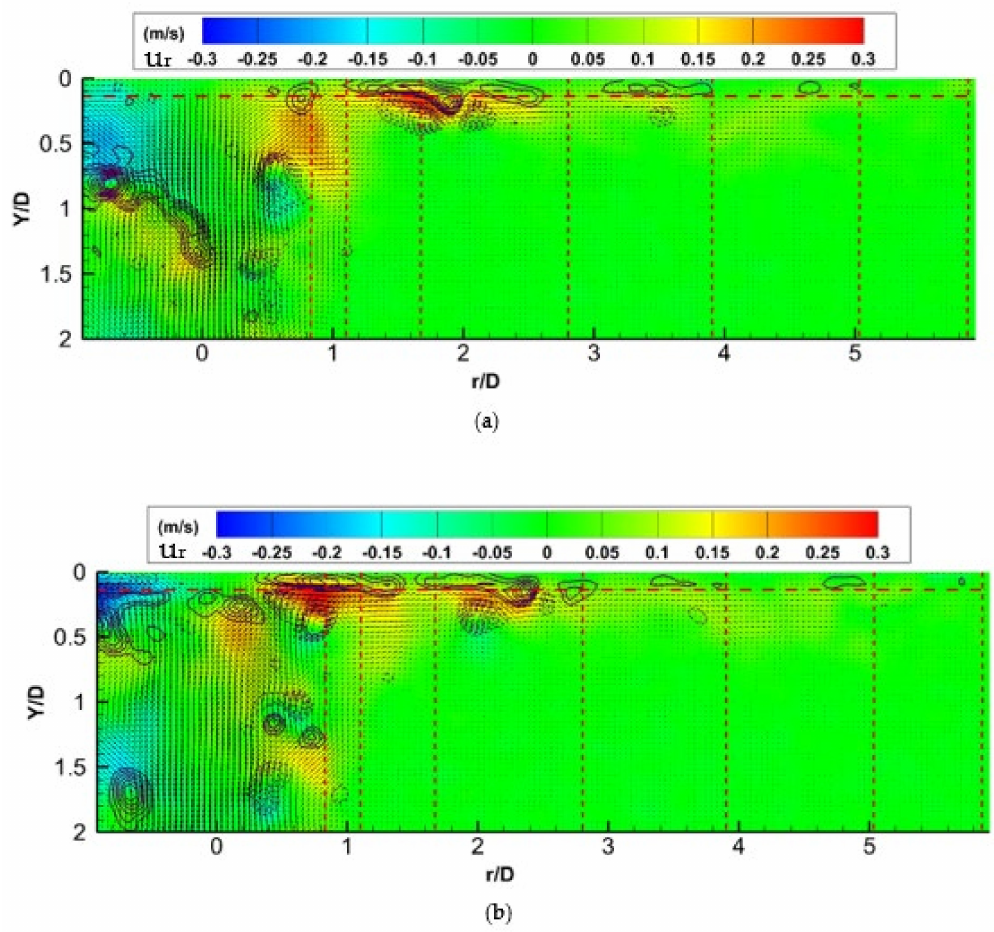
Figure 5. Instantaneous velocity fields for the rotational case ( a ) t = t1 and ( b ) t = t1 + 30 ms. Two representative snapshots of the velocity and DLE fields are shown in Figures 5 and 6 for the stationary and rotational cases, respectively. The time delay between the presented snapshot is 30